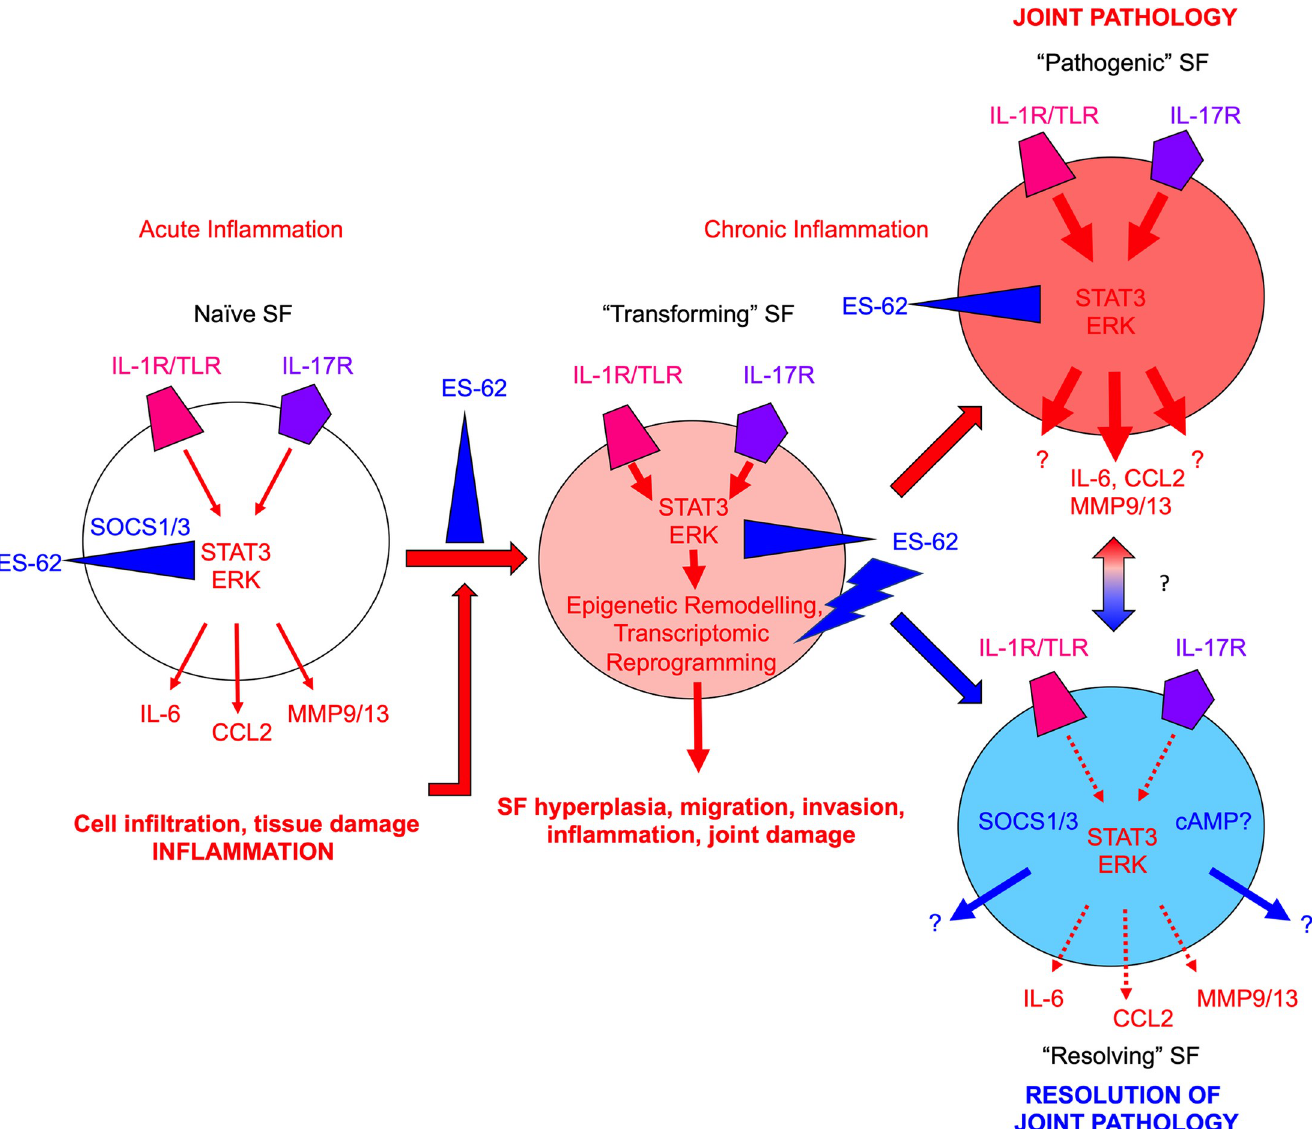
Fig 9. Model of ES-62 action in SFs during CIA. Healthy SFs (Na ï ve) respond to acute pro-inflammatory signals (e.g., IL-1 β /IL-17) in the joint microenvironment resulting in release of pathological mediators such as IL-6, CCL2 and MMP9/13, which cause cell (neutrophils, macrophages, lymphocytes) infiltration and tissue damage, resulting in chronic inflammation. In addition to perpetuating joint inflammation and damage, chronic inflammation drives rewiring of the epigenetic landscape and consequently, reprogramming of the SFs to a “pathogenic” aggressive hyperplastic, migrating and invasive phenotype that, via its hyper-responsiveness to environmental cues, plays a key role in joint pathology and destruction (all pathogenic signals denoted by red arrows with imprinted hyper-responsiveness represented by increased arrow size and redness of SF). ES-62 can disrupt this process at multiple points: thus, it can inhibit (blue blocking symbol) the (i) initial pro- inflammatory signalling to suppress acute inflammation; (ii) inflammatory signals generated by infiltrating cells and tissue damage to suppress induction of chronic inflammation; (iii) signalling associated with chronic inflammation to suppress transformation of SFs to an aggressive hyper-responsive phenotype and (iv) pathogenic signals in aggressive SFs during established disease. Consistent with our findings that ES-62 does not simply maintain/restore the Na ï ve-SF phenotype, it also exhibits positive actions (blue lightning bolt symbol), specifically inducing epigenetic remodelling (perhaps of an intermediate anti-inflammatory SF phenotype, generated by inhibition of pathogenic ERK and STAT3 signalling) that reprograms the cell to an inflammation-resolving and tissue repair phenotype. The potential ability of the “resolving” ES-62-CIA-SFs to also directly influence the behavior of “pathogenic” SFs in the joint during established disease is represented by the red- blue gradient